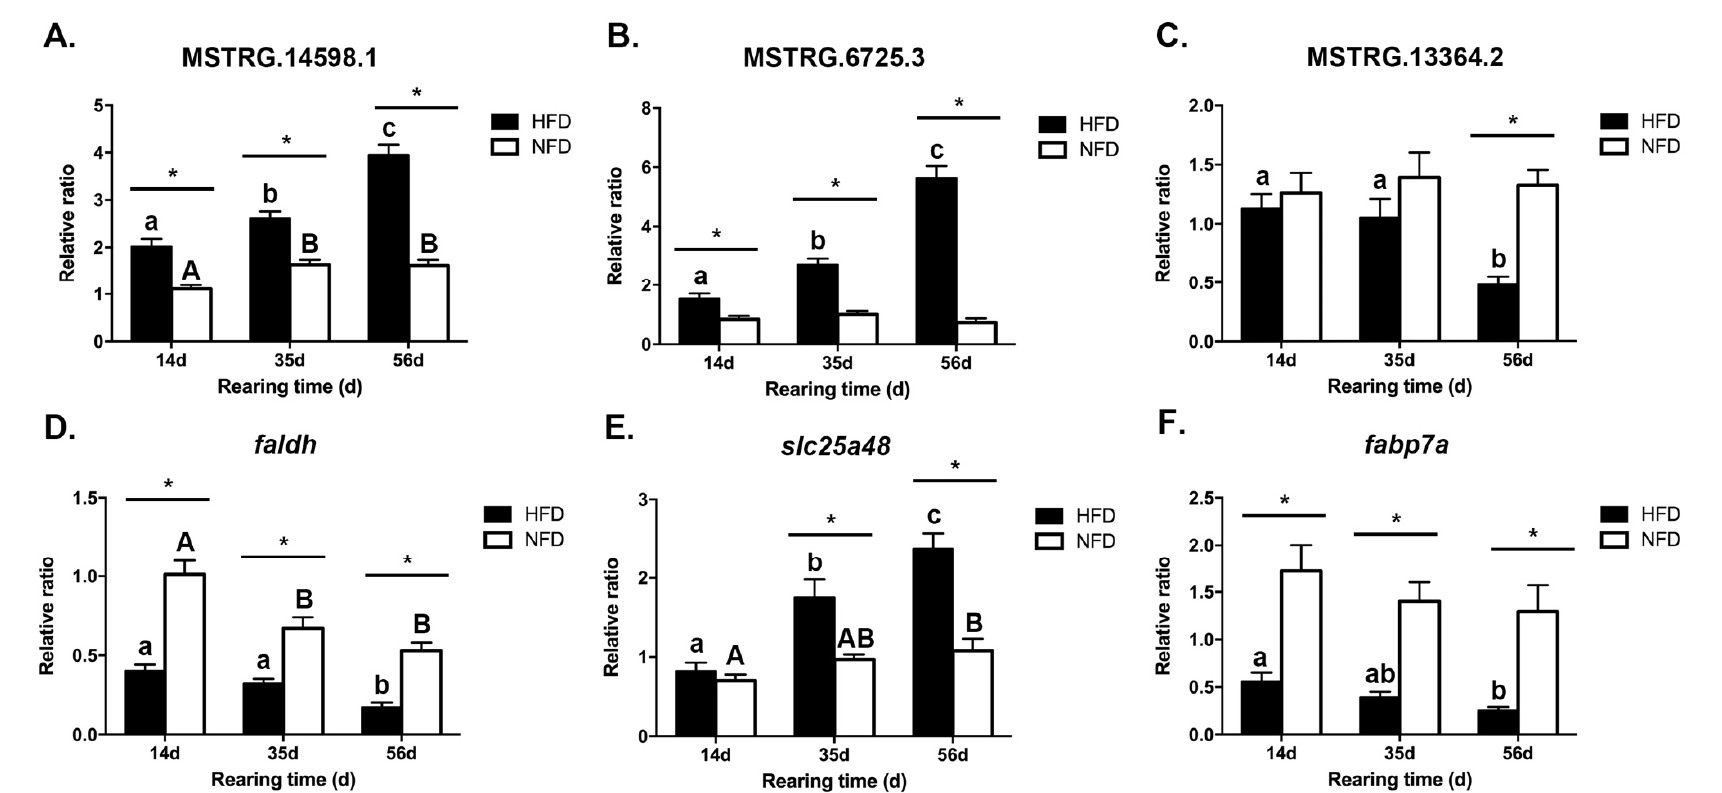
Figure 7. Expression patterns of selected DE-lncRNAs and their lipid metabolism-related target mRNAs in the liver in the HFD group on days 14, 35, and 56. ( n = 9). ( A ) MSTRG.14598.1; ( B ) MSTRG.6725.3; ( C ) MSTRG.13364.2; ( D ) faldh ; ( E ) slc25a48 ; ( F ) fabp7a . * indicates significant difference ( p < 0.05) between HFD and NFD groups at the same sampling time; different lowercase letters indicate significant difference ( p < 0.05) in the HFD group among different sampling times. Different capital letters indicate significant difference ( p < 0.05) in the NFD group among different sampling times.